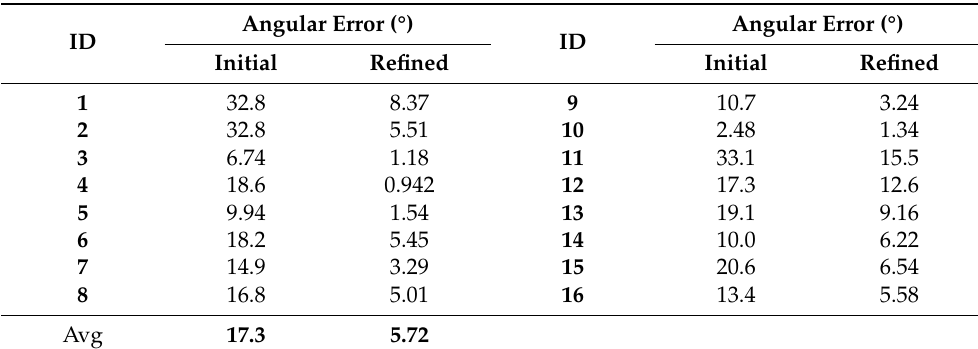
Table 2. ROI detection experiment result. The Angular Error (°) denotes angle difference between the ROI tangent image (ROI-TI) coincident point C T and the ground truth coincident point C GT . The “Initial” represents the angular error between the C ROI and the C GT before the refinement process; the “Refined” represents the angular error between the C ROI and the C GT after the refinement process. The “Refined” error is the final ROI-TI C T error to C GT . Angular Error (°) ID Initial Refined 1